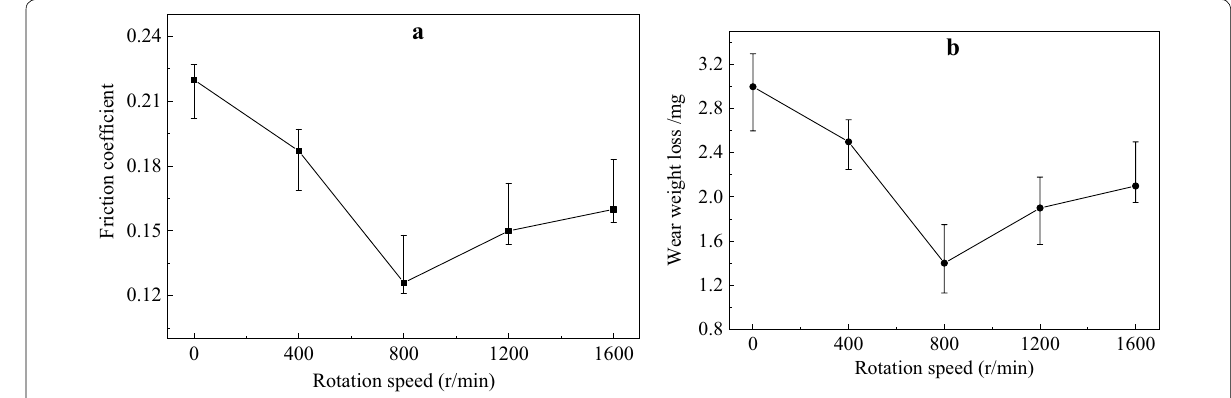
Figure 7 Effect of the supergravity field on: a the friction coefficient, and b the wear weight